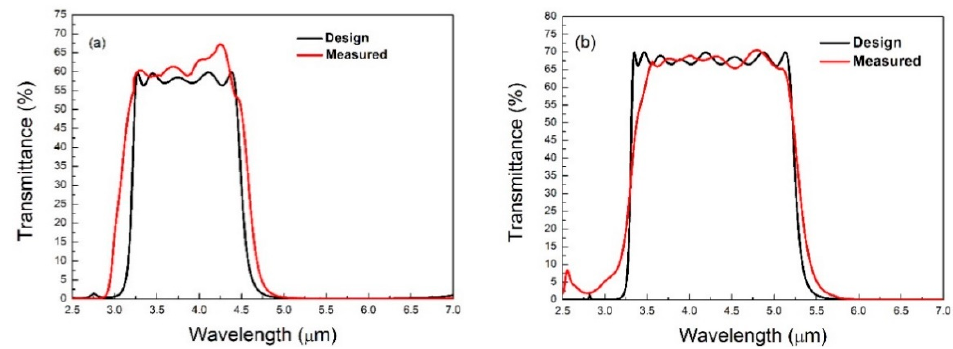
Figure 3. Transmission spectrum of ( a ) 20-layer; ( b ) 23-layer BPFs. The internal stress of the single-layer Ge and SiO 2 films were − 1.775 ± 0.275 GPa and − 0.588 ± 0.039 GPa, respectively. The compressive stress of the Ge single-layer film was